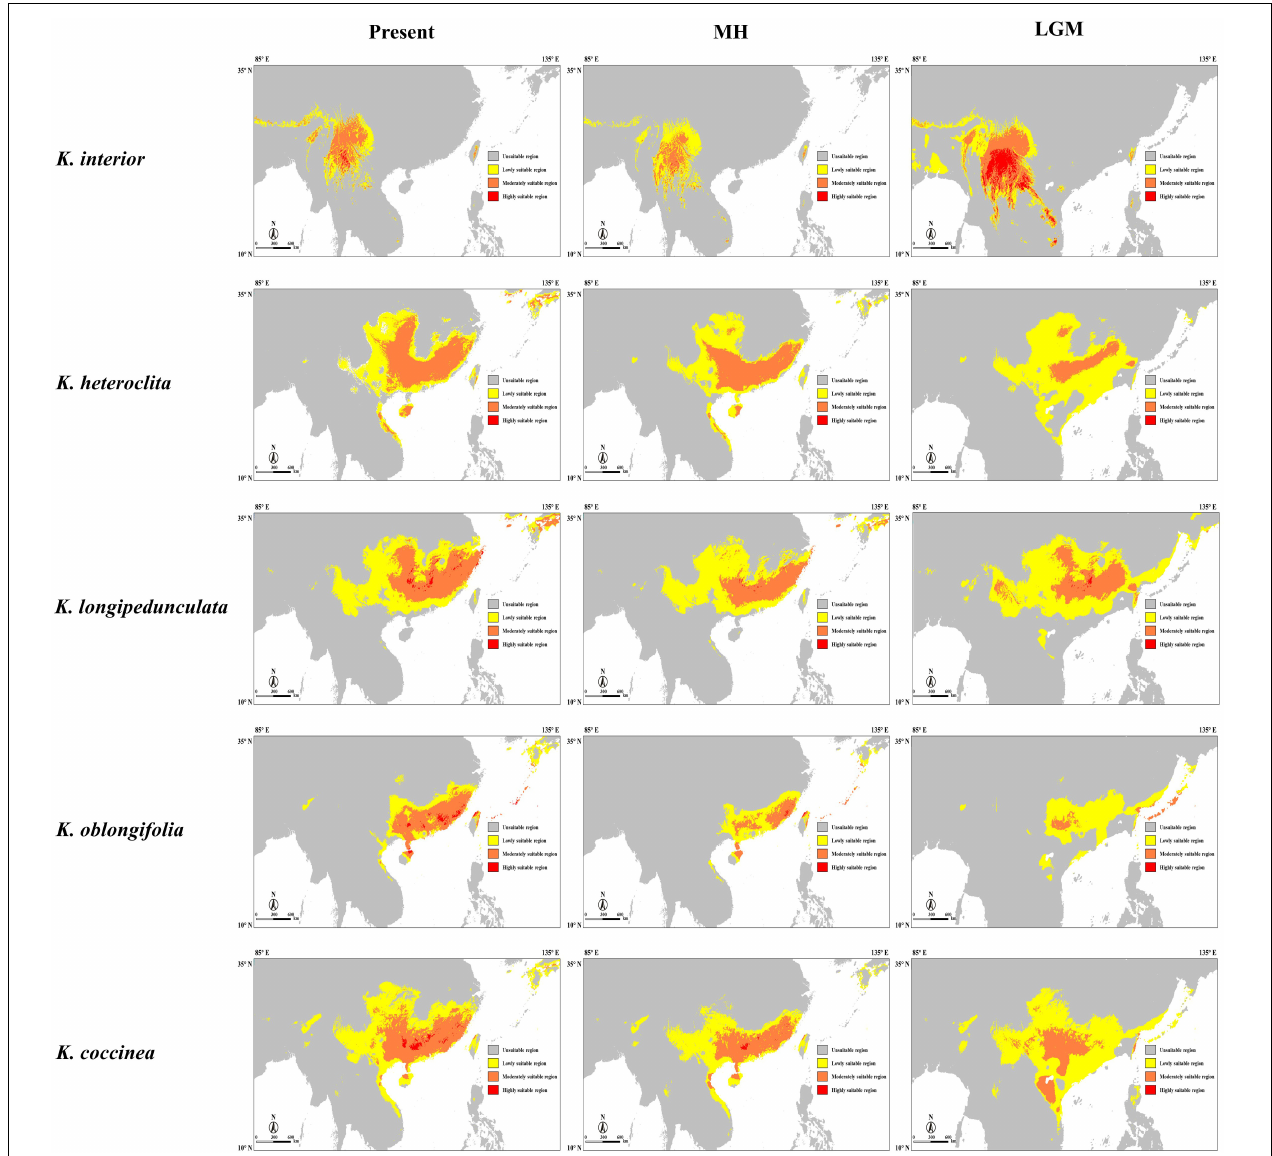
FIGURE 5 | Habitat suitability of K. interior and its related species predicted by Maxent for the present, mid-Holocene (MH), and last Maximum Glacial (LGM). The suitable area is divided into three gradients according to the threshold from low to